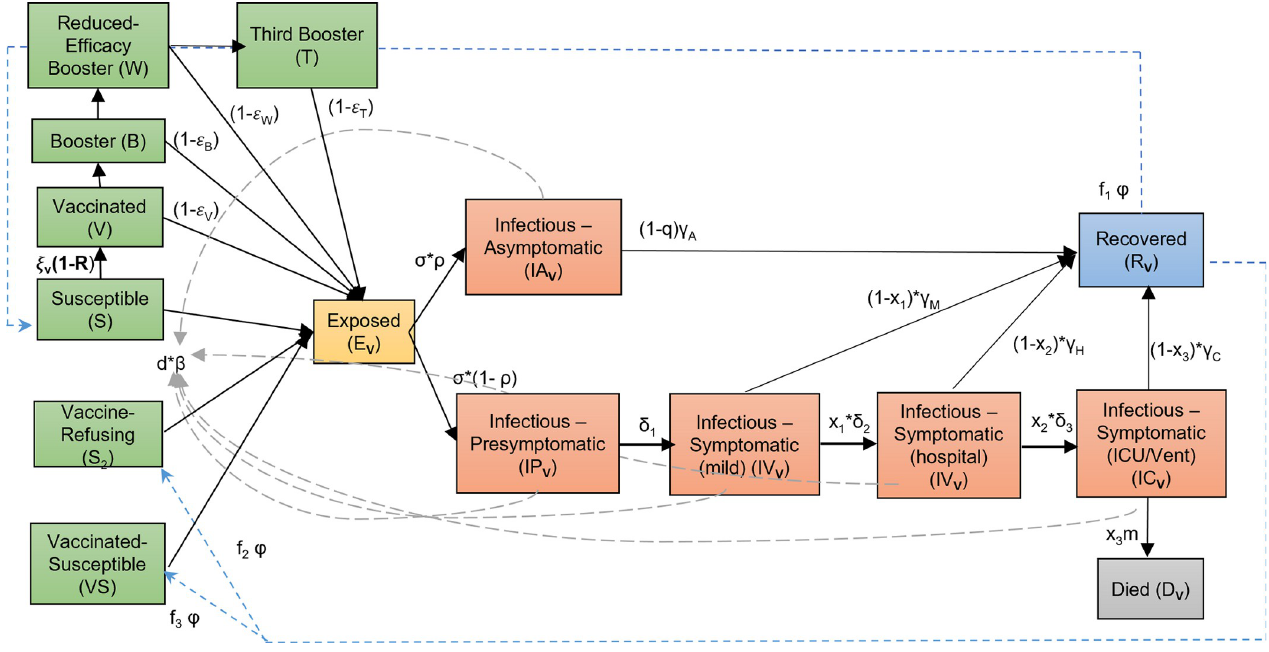
Fig 1. Expanded SEIR model flowchart. Each compartment represents a distinct state of infection, with arrows indicating flows between compartments.